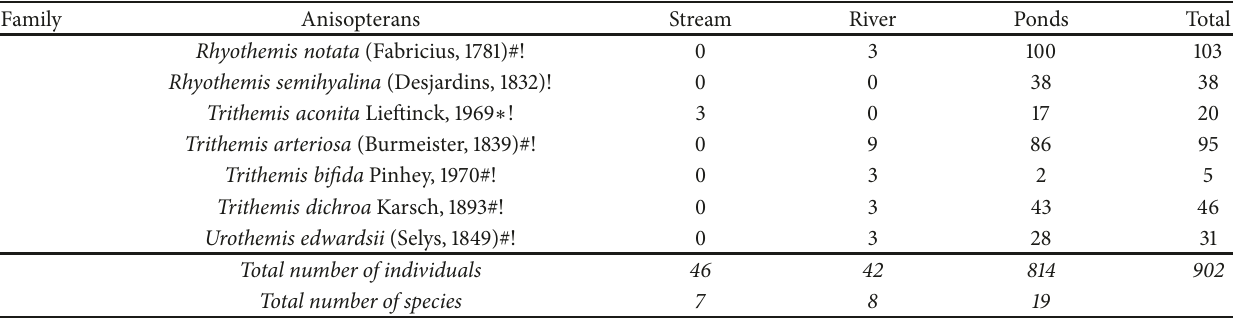
Table 2: Results of the broken stick model for the abundance rank distribution of Odonata species, calculated for each of the three water types. Sample Intercept ± S.E.